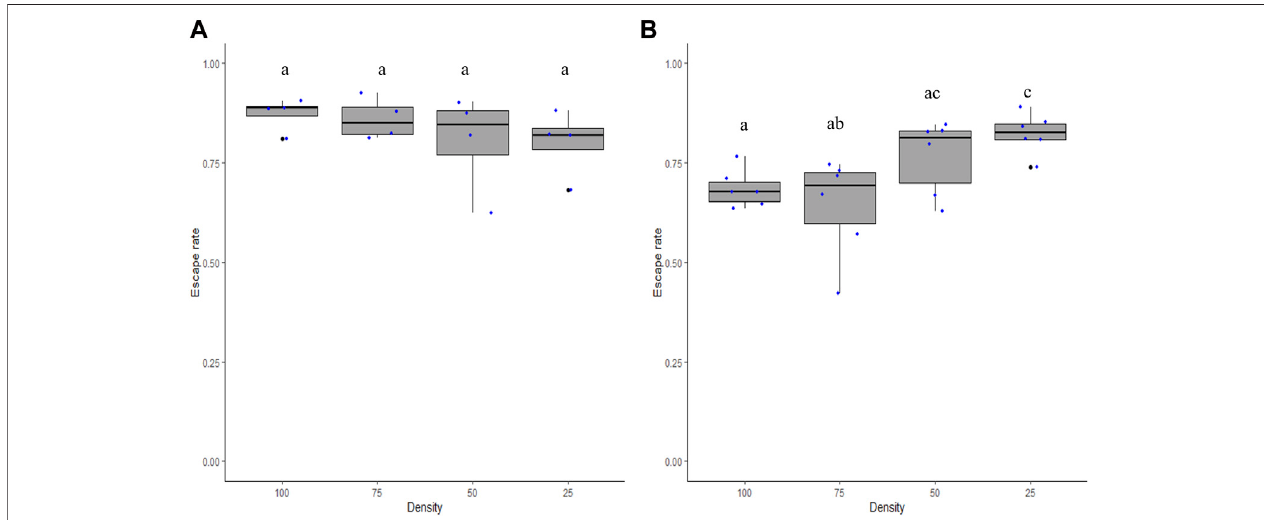
FIGURE4| Escaperatesaccordingtomaledensityfor Aedesaegypti (A) and Aedesalbopictus (B) .Numbers(25,50,75,and100)standfortheadultmaledensity loaded in each fl ight test device. Different letters denote signi fi cant differences between densities.